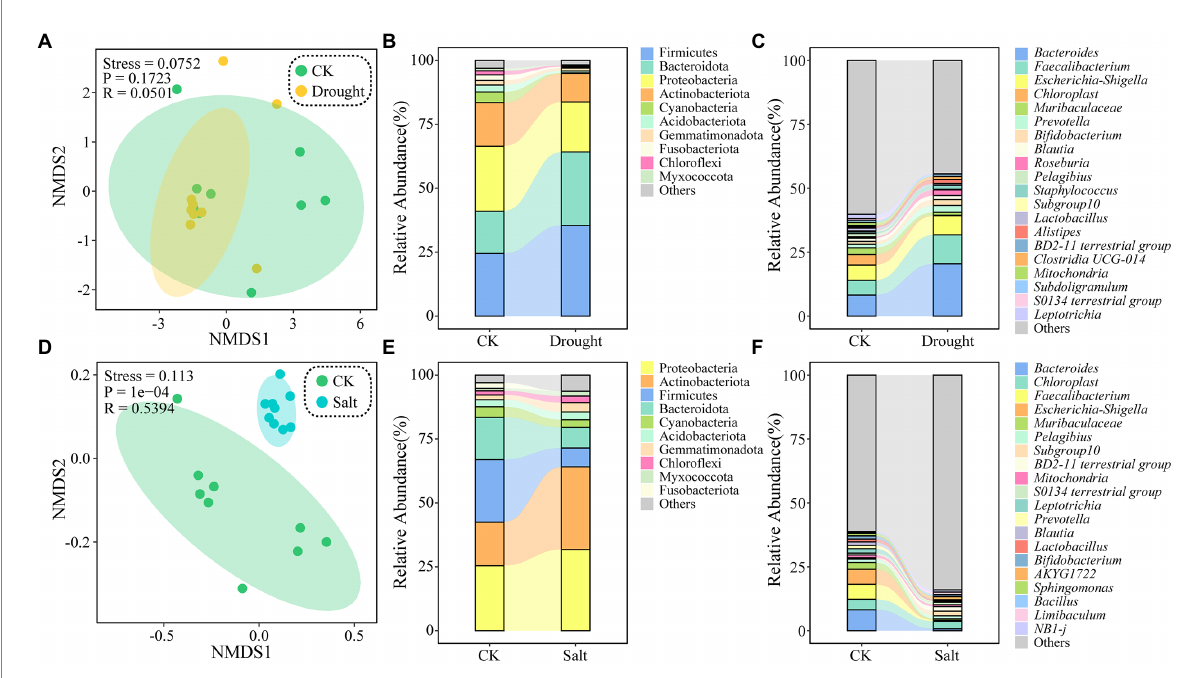
FIGURE 2 Non-metric multidimensional scaling (NMDS) ordination based on Bray Curtis similarities of bacterial communities under drought (A) and salt (D) stress. Each point represents a replicate, different colors indicate different sample plots. Relative abundance of major taxa (top 10) in the bacterial communities under drought (B) and salt (E) stress at the phylum level. And relative abundance of major taxa (top 20) in the bacterial communities under drought (C) and salt (F) stress at the genera